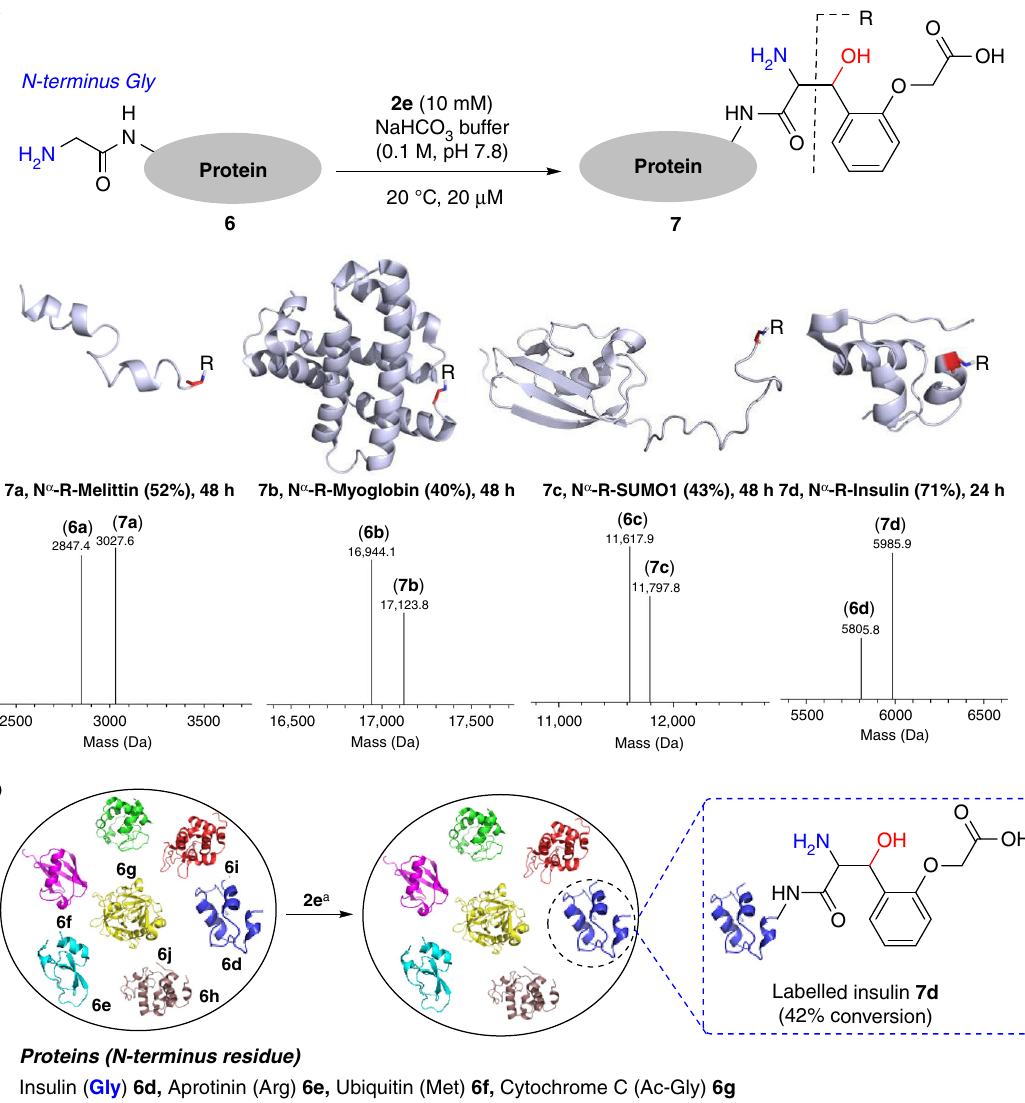
Fig. 3 N-terminus Gly labeling of proteins. a A user-friendly protocol delivers single-site labeling of proteins. Deconvoluted ESI-MS con fi rms the % conversion and rules out the possibility of side reactions (also see Supplementary Figs. 70 and 71). R indicates the fragment from reagent 2e attached to the protein. b Extension of methodology for labeling single protein (insulin 6d ) in a mixture of proteins ( 6d – 6j